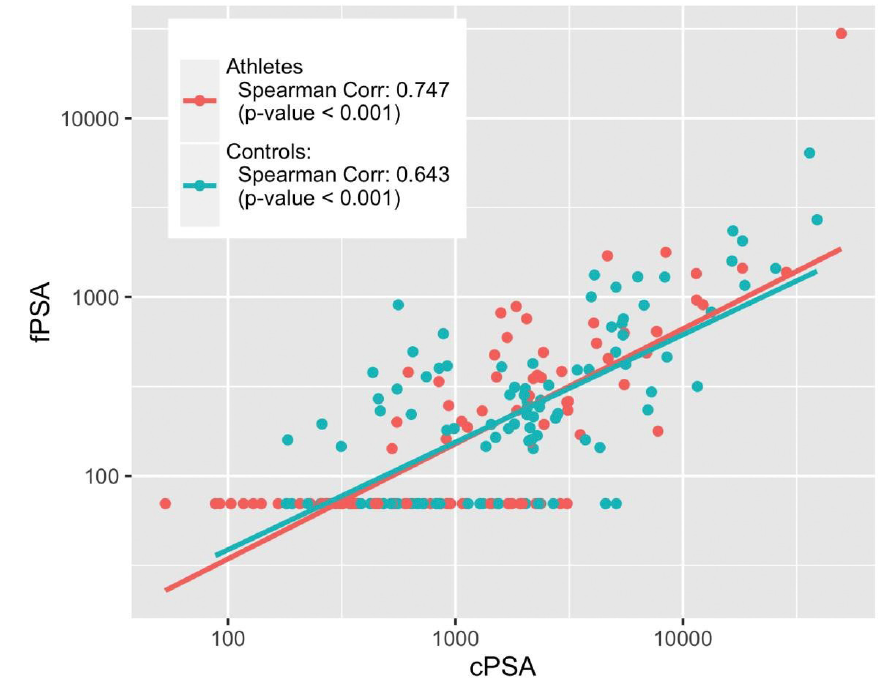
Figure 1. Serum fPSA vs. cPSA in athletes and controls. Spearman correlations (p-values) are shown.